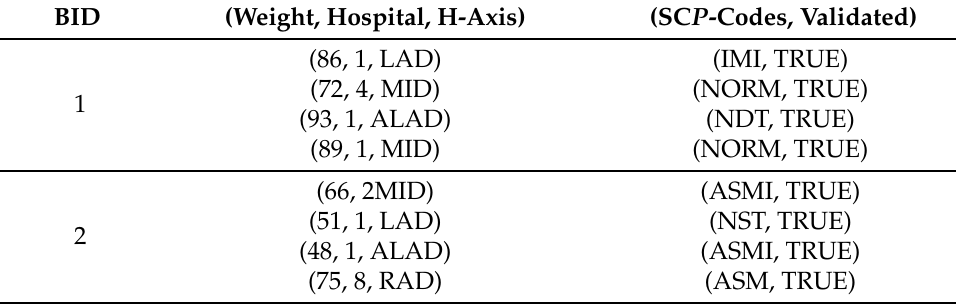
Table 11. l -diverse sliced males’ SAs